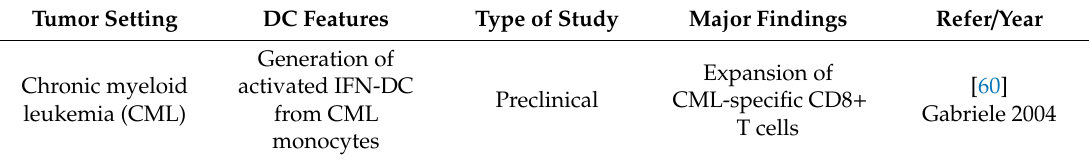
Table 1. Major preclinical and clinical studies testing IFN-DC in cancer immunotherapy. Tumor